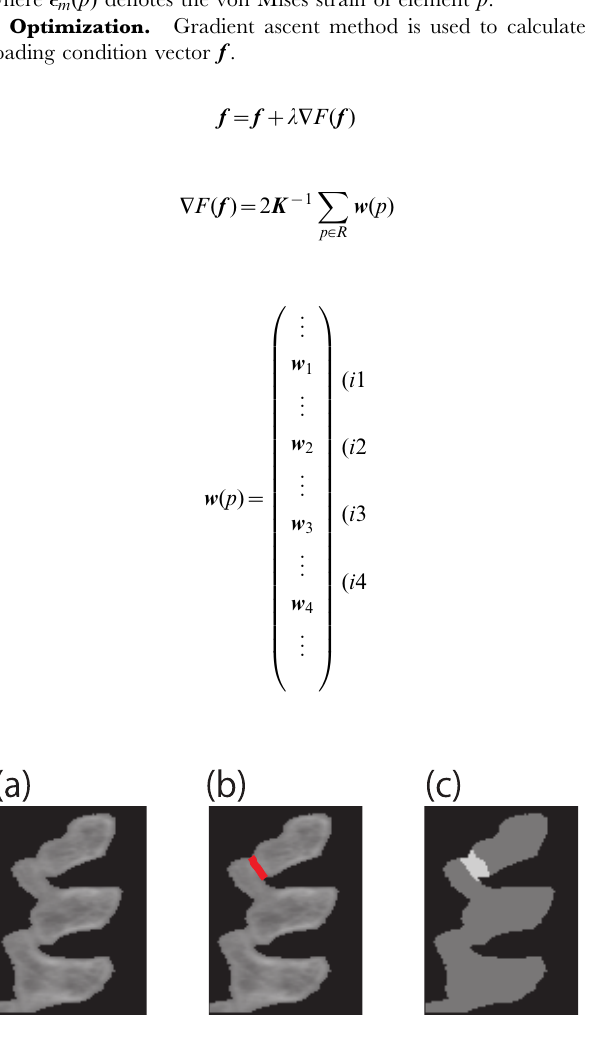
Figure 4. ROI setting. (a) is Input image D f , (b) is Interference region, and (c) is ROI R . (a) is the input foreground image. The red line in (b) indicates an interference region. The white area in (c) is user specified ROI R ( 5 D f ) .